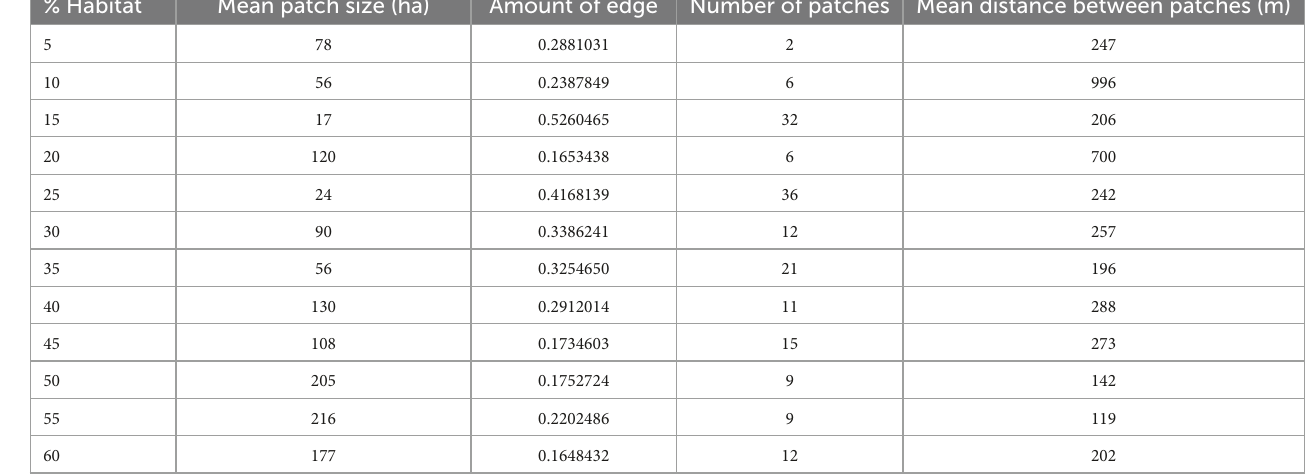
TABLE 3 Metrics of the sampled